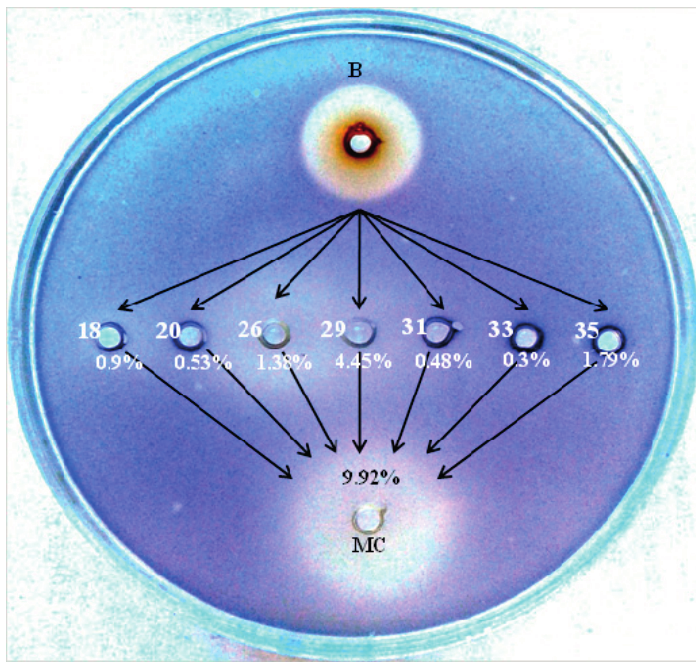
Figure 4. Comparison of bioactivity of original Quercus cortex “B” sample,